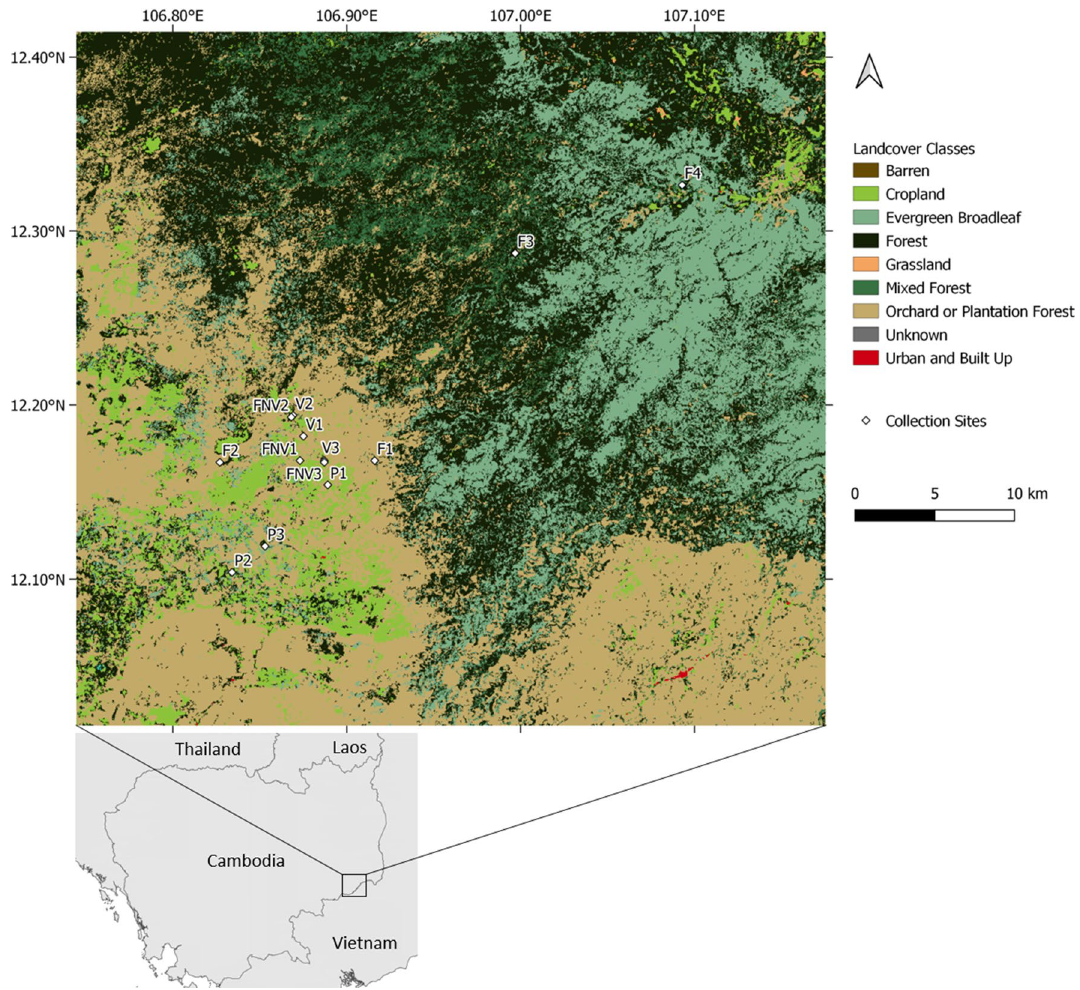
Figure 1. Map of the mosquito collection sites in Kaev Seima district, Mondulkiri, Cambodia. Land use map from Landsat satellite imagery retrieved from SERVIR Mekong (https:// landc overm apping. org/ en/).